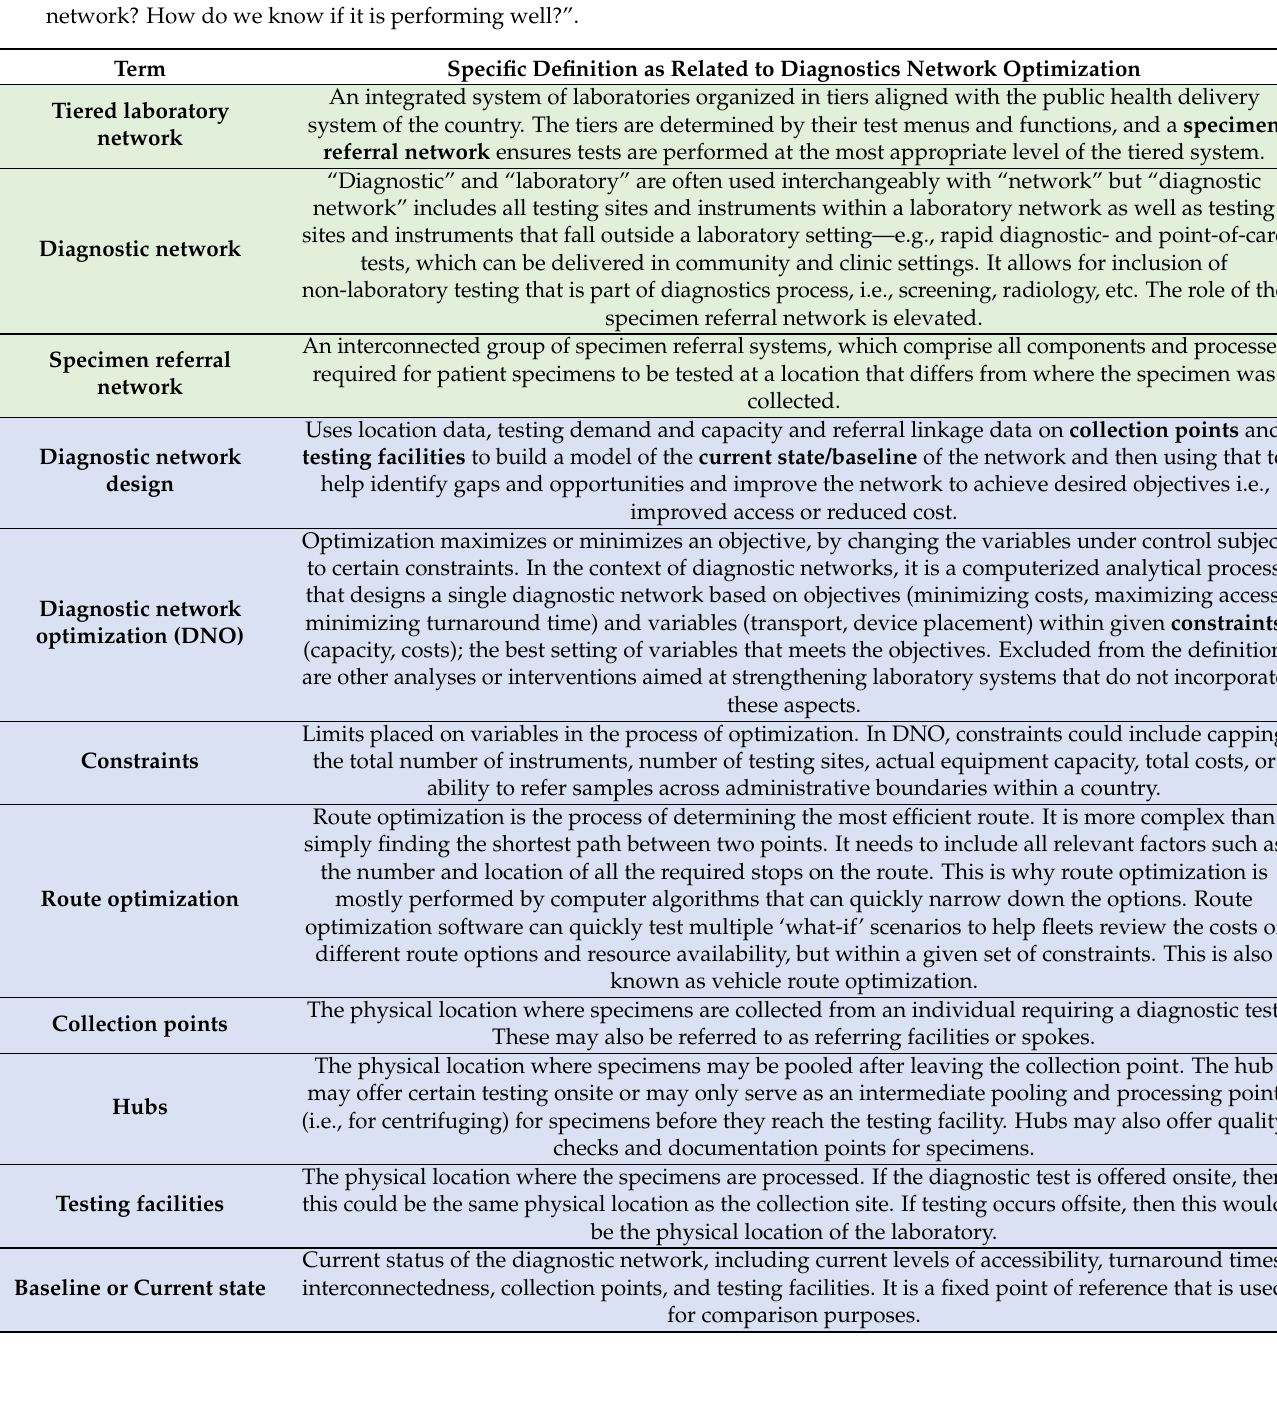
Table 1. Terms and definitions related to diagnostic network design and optimization. Terms highlighted in green address, “What is a diagnostic network and how does it compare to a laboratory network?”; items in blue address, “How can we improve the diagnostic network through analysis?”; and terms in yellow address, “What are the objectives of a diagnostic network? How do we know if it is performing